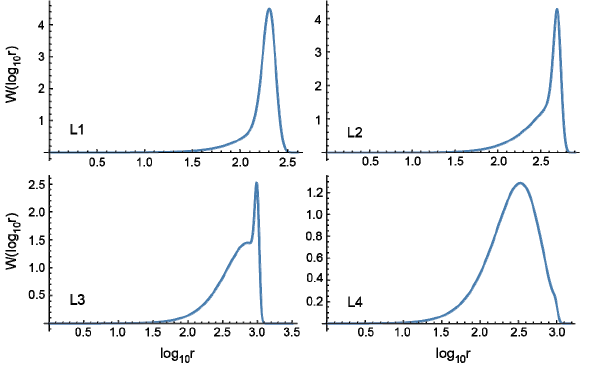
Figure 6. Primary polymer chain length distribution of the present model living emulsion polymerization for the conditions L1–L4, calculated from Equation (23).